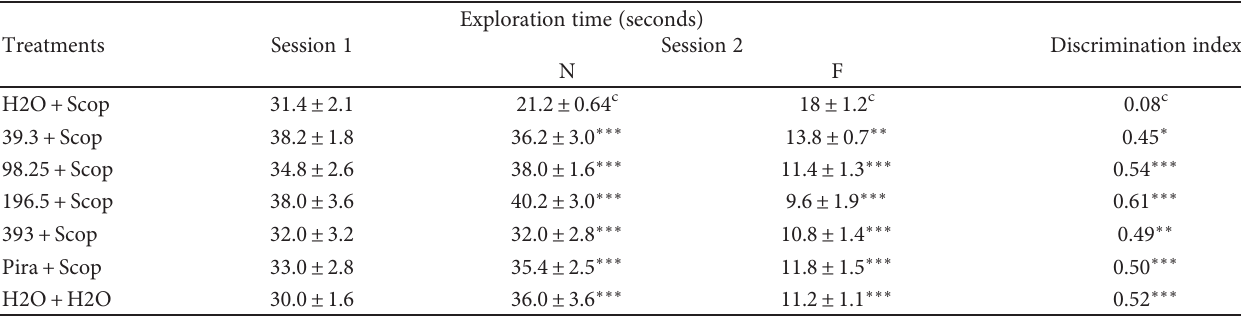
Table 4: E ff ect of M. inermis in scopolamine-induced cognitive de fi cit mice in ORT.